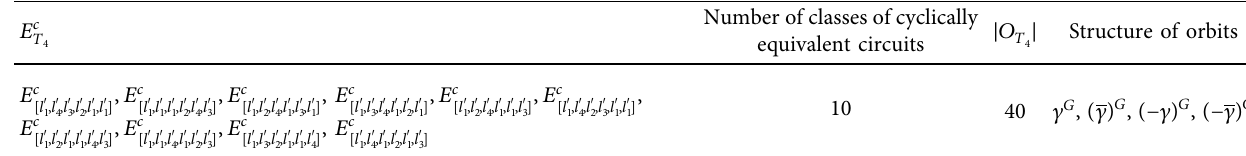
Table 8: Cyclically equivalent classes of T